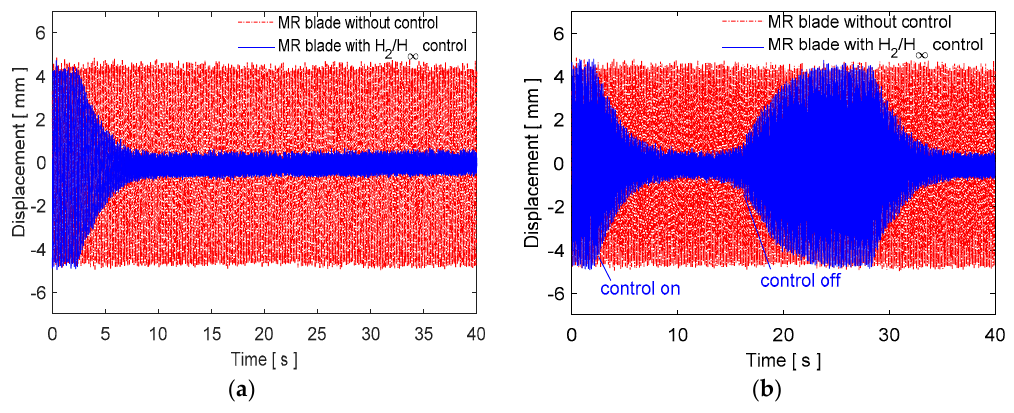
Figure 16. Experimental results of the closed loop system under steady state aerodynamic load ( a ) continuous control, ( b ) repeated control.